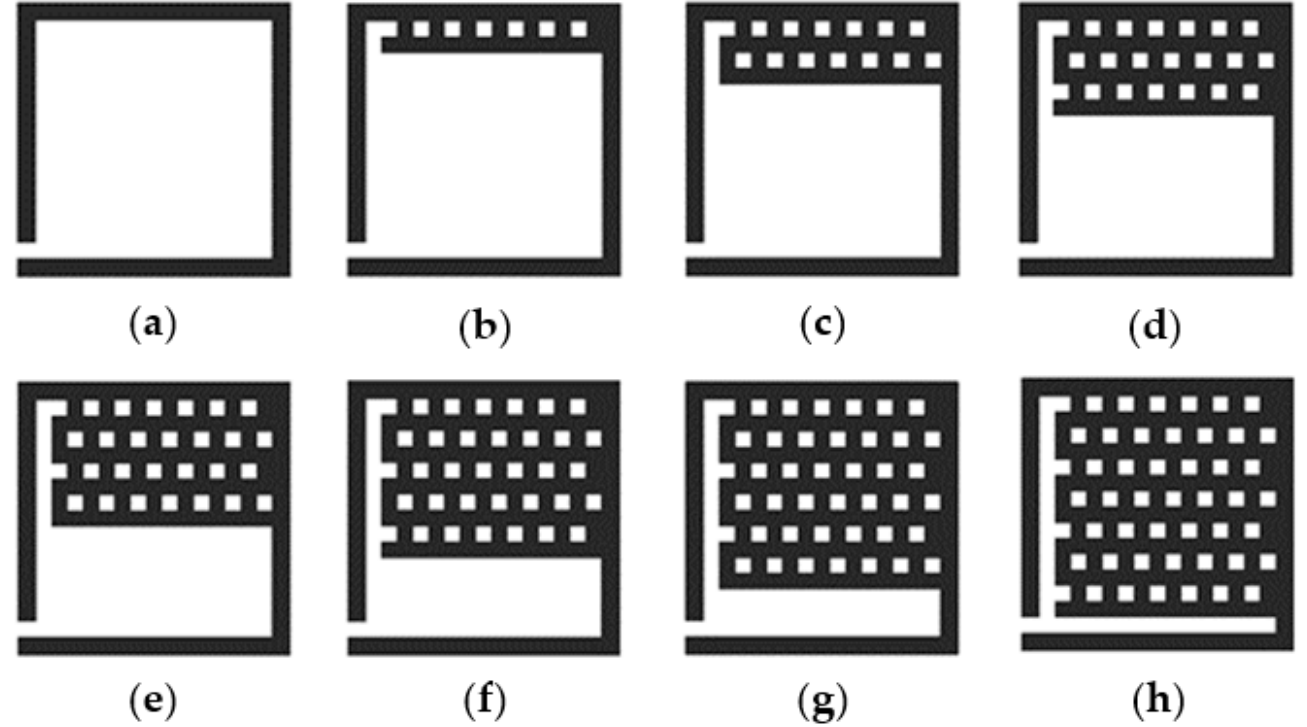
Figure 4. Layout of square mesh open-loop resonators: ( a ) 7.5 GHz; ( b ) 8 GHz; ( c ) 8.4 GHz; ( d ) 8.9 GHz; ( e ) 9.5 GHz; ( f ) 10.06 GHz; ( g ) 10.37 GHz; ( h ) 10.89 GHz.